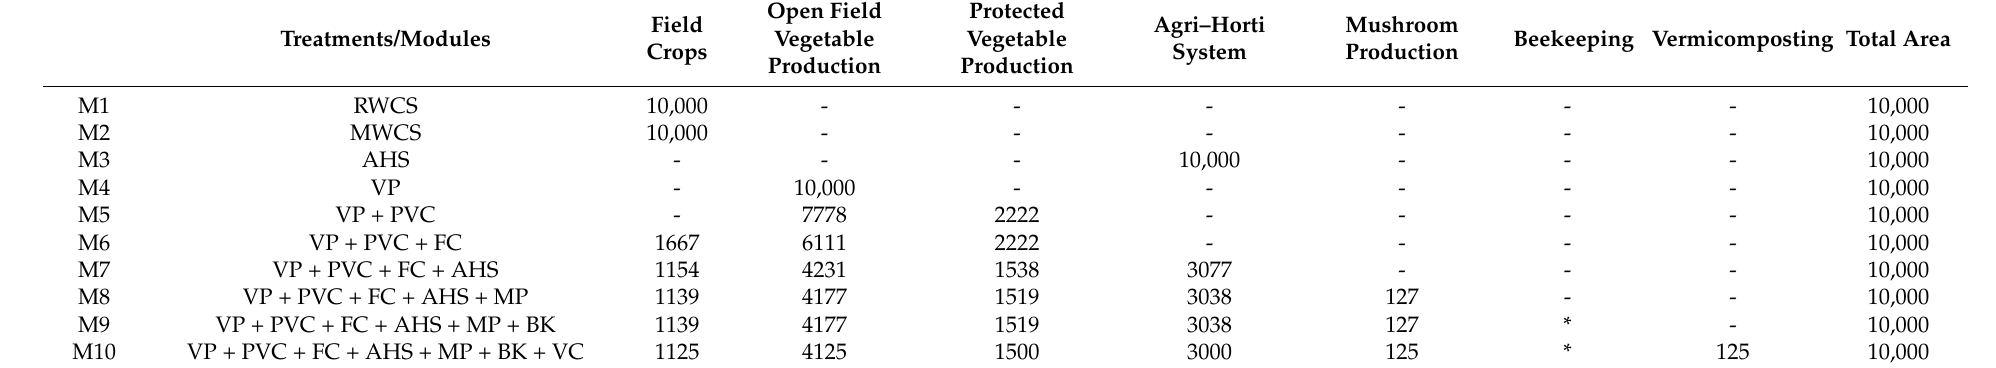
Table 2. Area allocation (m 2 ) for different modules on a hectare basis of the integrated farming system model. Treatments/Modules